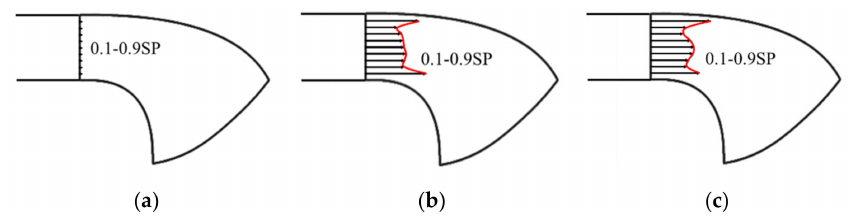
Figure 9. Distribution profiles of radial velocity at typical times. ( a ) t = 0 s; ( b ) t = 7 s; ( c ) t = 20 s.